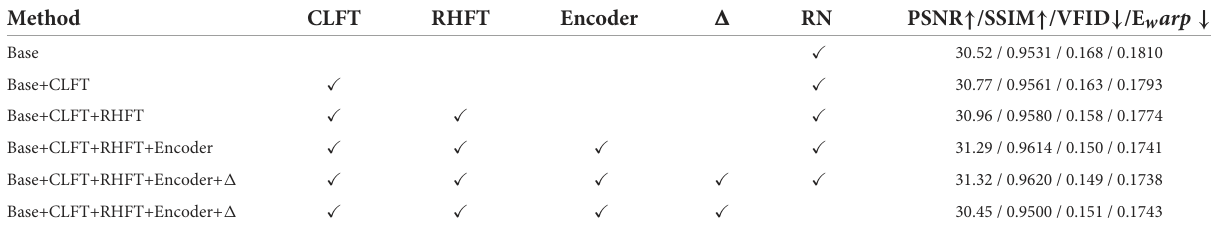
TABLE 2 Effects of various parts of texture transfer.